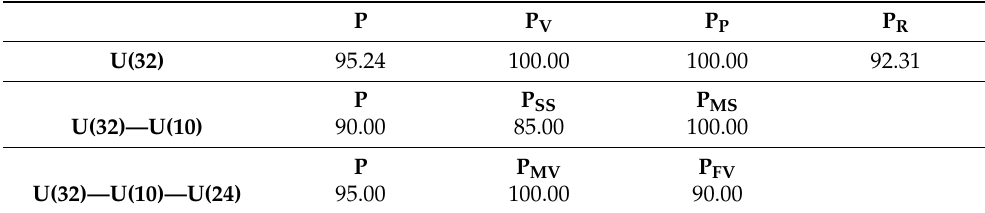
Figure 7. Feature evaluation for MF scheme. Table 8. Clustering performances with feature